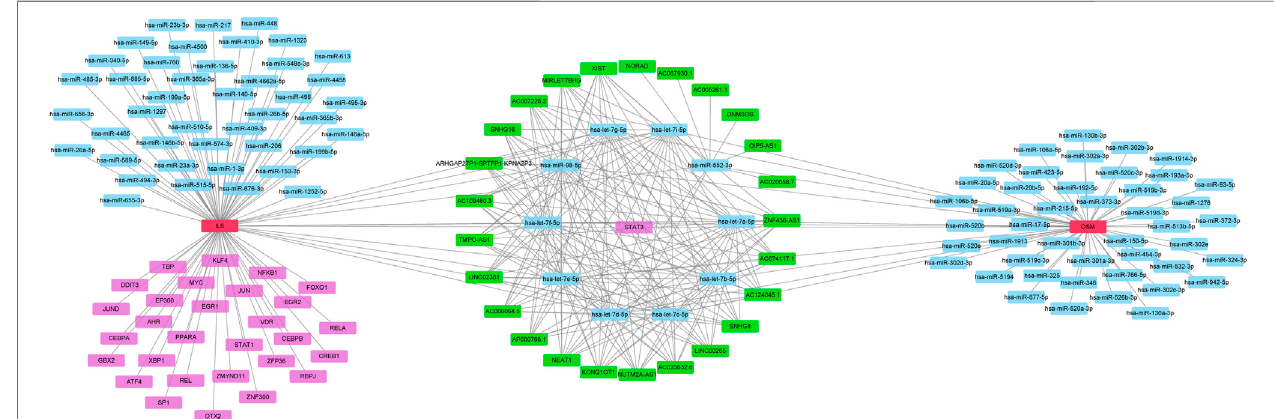
FIGURE 6 | Multi-factor regulation network for IL-6 and OSM.